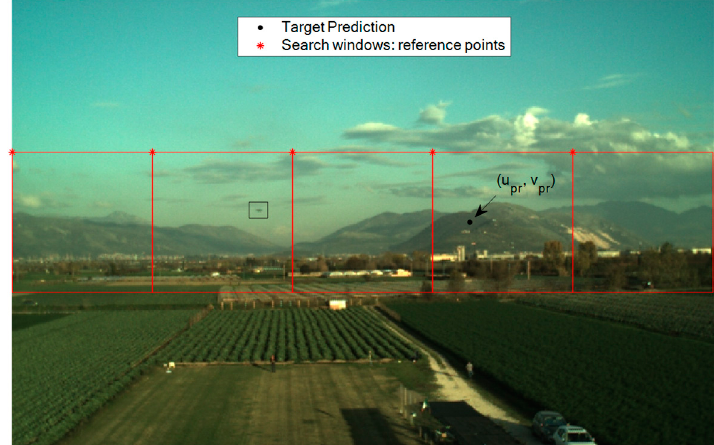
Figure 3. DL-based detector: example of search windows definition for a 752 × 480-pixels RGB image. d u is set to 150 pixels ( N w = 5). The target UAV position is highlighted by a black box.